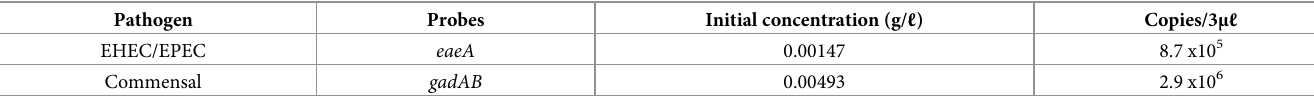
Table 1. Starting template concentration added for the standard curves. collected from Colilert 1 Quanti-Trays 1 wells containing Coliform growth from environmen- tal water samples as described by Omar et al. [5].